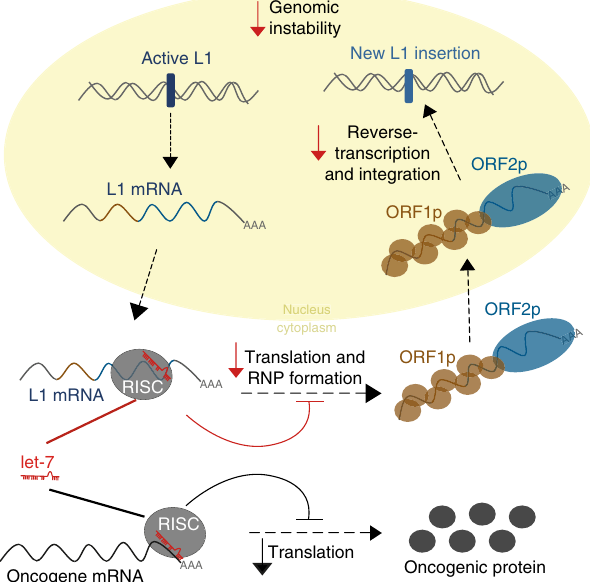
Fig. 6 Model for the control of LINE-1 retrotransposition by the tumor suppressor miRNA let-7. Besides the well-known regulation of oncogenes (lower part of the scheme in gray), we propose a novel tumor-suppressor role for let-7 miRNAs (upper part of the scheme in color). Once LINE-1 RNA is transcribed from an active L1 located in the genome and is exported into the cytoplasm, let-7 (drawn in red) binds and guides the RISC complex (gray circle) to the L1 mRNA (blue line). This binding leads to the inhibition of ORF2p translation (blue circle) and consequently, impairs the formation of the ribonucleoparticle (ORF1p (brown circle) and ORF2p (blue circle)). The reduction in ORF2p levels results in a decrease in the reverse transcriptase activity in the nucleus and the number of new L1 copies integrated in the genome, consequently, reduces the L1-associated genomic